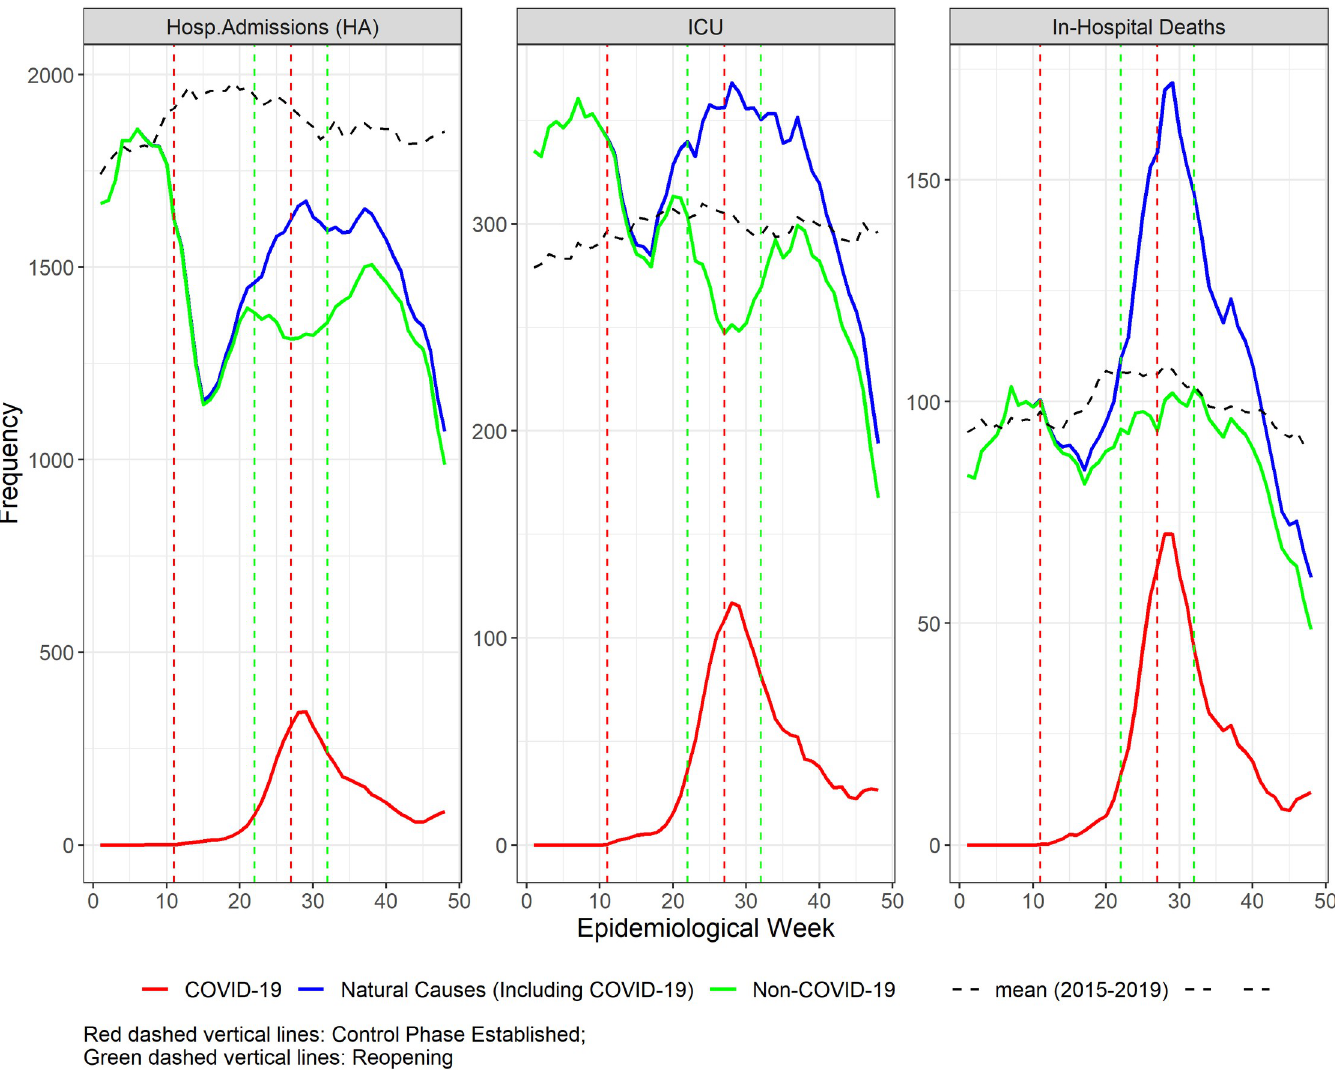
Fig 1. Five-week moving average of number of hospital admissions, intensive care unit admissions, and in-hospital deaths in Belo Horizonte, epidemiological weeks (EW) 1 to 48, 2020 (solid lines), and the mean of the same EW of 2015–2019 (dashed line) for: All natural causes (green), non-COVID-19 natural causes (blue), and COVID-19 (red). Vertical lines refer to the weeks of control (red) and reopening phases